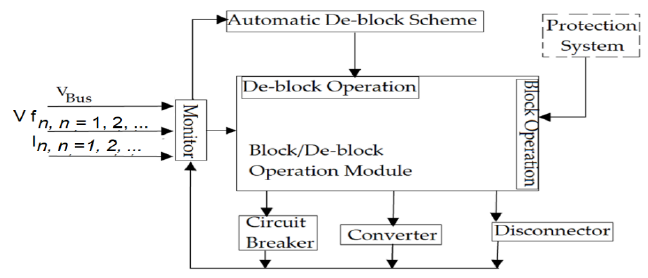
Figure 6. Proposed diagram of converter restoration